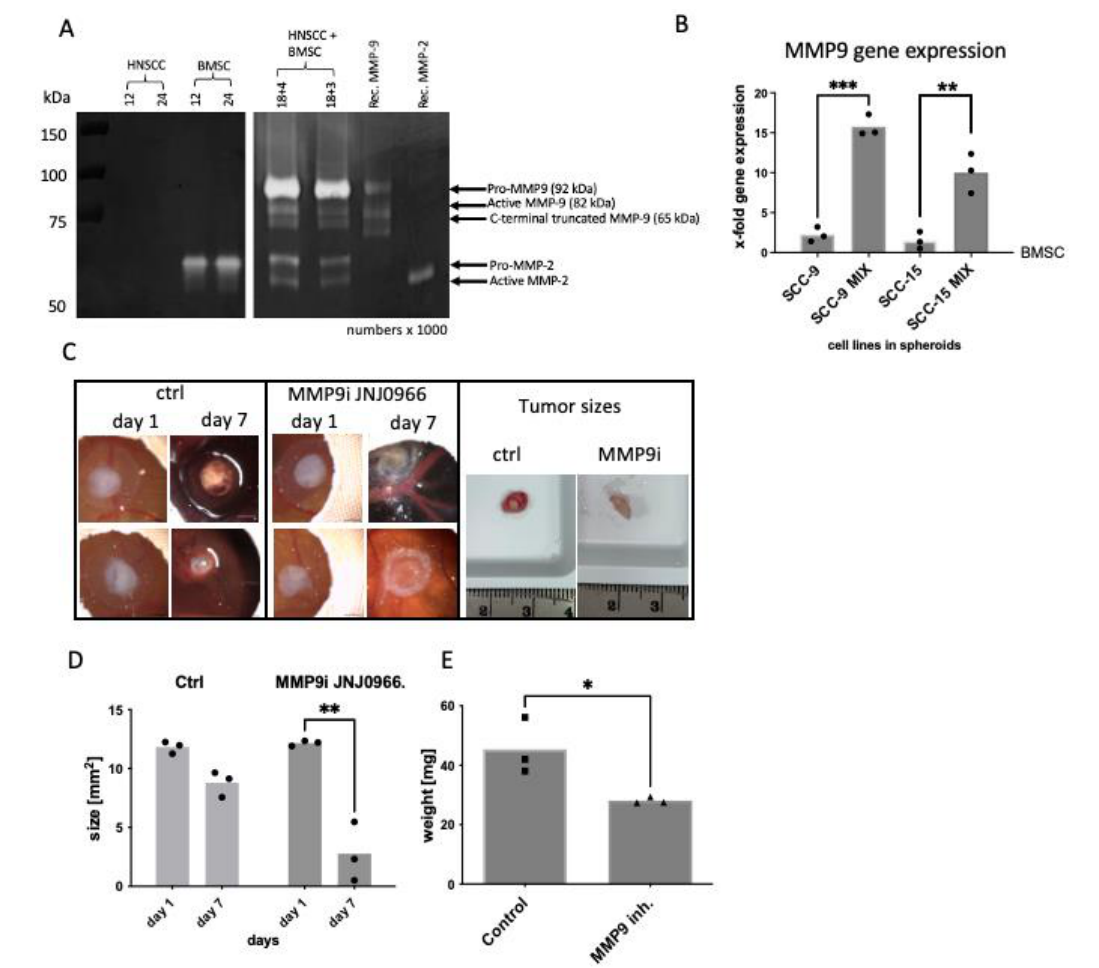
Figure 2. ( A ): Exemplary zymography depicting the exclusive expression and secretion of MMP-9 in the BMSC/HNSCC co-culture 3D spheroids (mix) compared to HNSCC and BMSC mono-culture 3D spheroids. Left panel: Supernatants of HNSCC cells and BMSC mono-culture 3D spheroids with 12,000 or 24,000 cells, respectively. Right panel: BMSC/HNSCC co-culture with 18,000 tumor cells each and 4000 or 3000 BMSCs. With 3000 BMSCs, the detection of active MMP-9 decreases. The pro-form of MMP-9 is strongly expressed in all mixtures. ( B ): Taqman quantitative PCR revealed that MMP-9 was also significantly increased in the mixture compared with the mono-cultures in the CAM model. ( C – E ): Specific MMP-9 inhibitor (MMP9i, JNJ0966, Selleckchem, Houston, TX, USA) stopped the severe hemorrhage of the mixtures and significantly reduced tumor size and weight in the CAM model (see also Supplementary Figure S1). n = 3, numbers × 1000. HNSCC: head and neck squamous cell carcinoma cell lines, BMSC: bone marrow-derived stromal cells, Rec. MMP: recombinant MMP controls. Unpaired t -test: * p < 0.05; ** p < 0.01; *** p < 0.001.